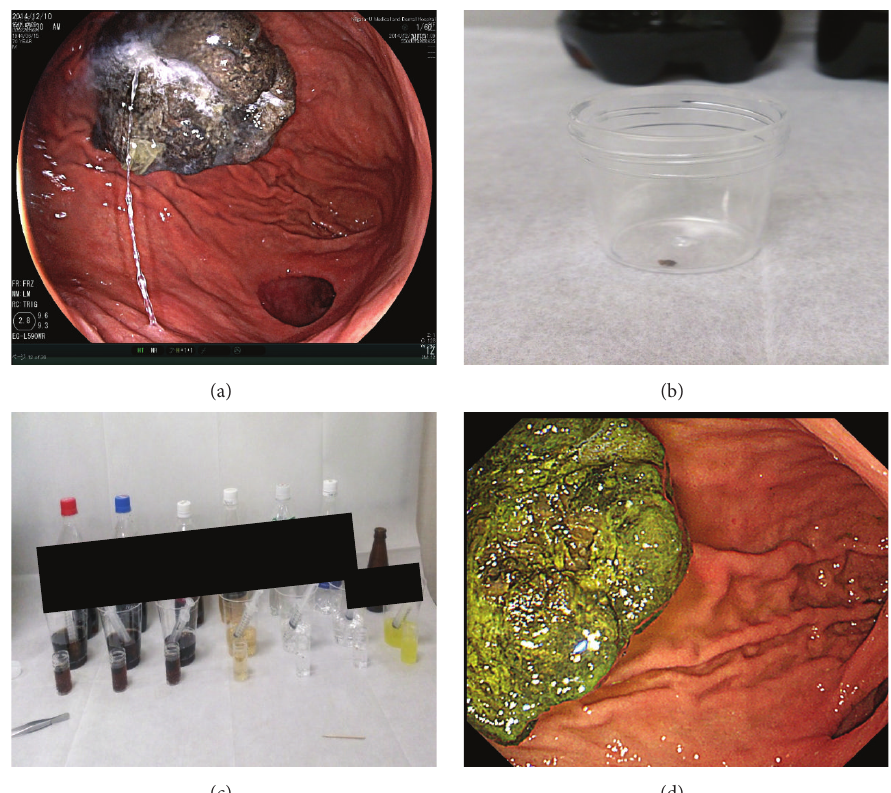
Figure 2: (a) Approximately 5cm of the black bezoar in the remnant stomach before the dissolution therapy. (b, c) Small pieces of the bezoar had their solubility examined in seven different carbonated liquids. (d) The size and color of bezoar after the dissolution therapy using the liquid showed the highest dissolution effect in